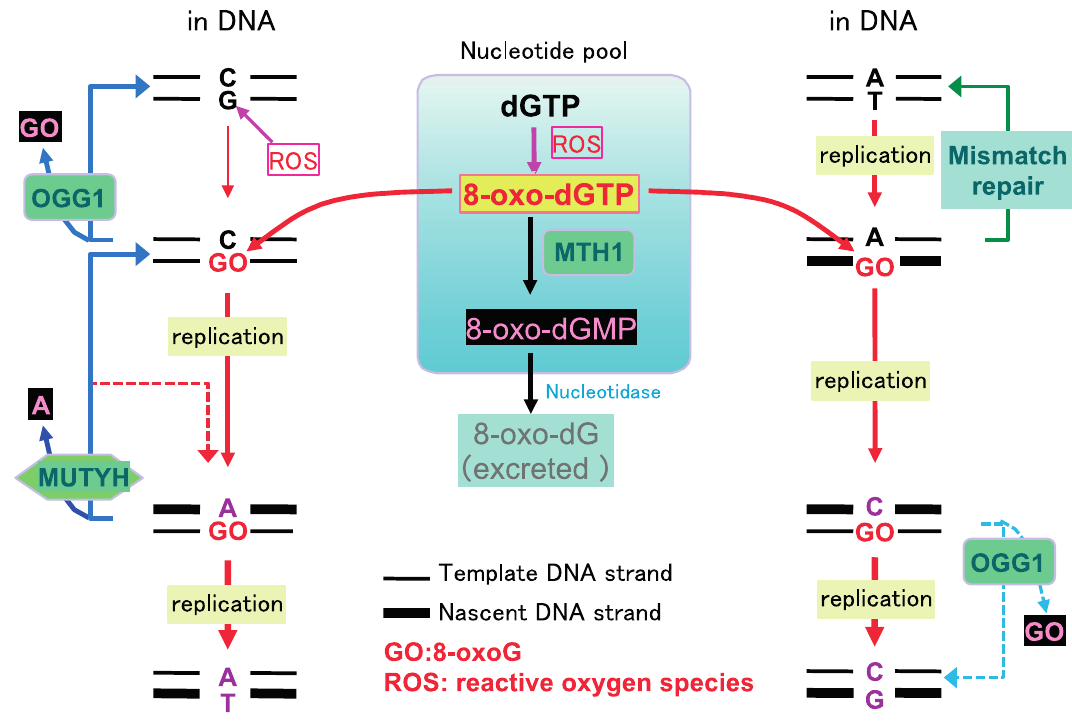
Figure 2. Mutagenesis caused by 8-oxoguanine and mammalian defense systems. In